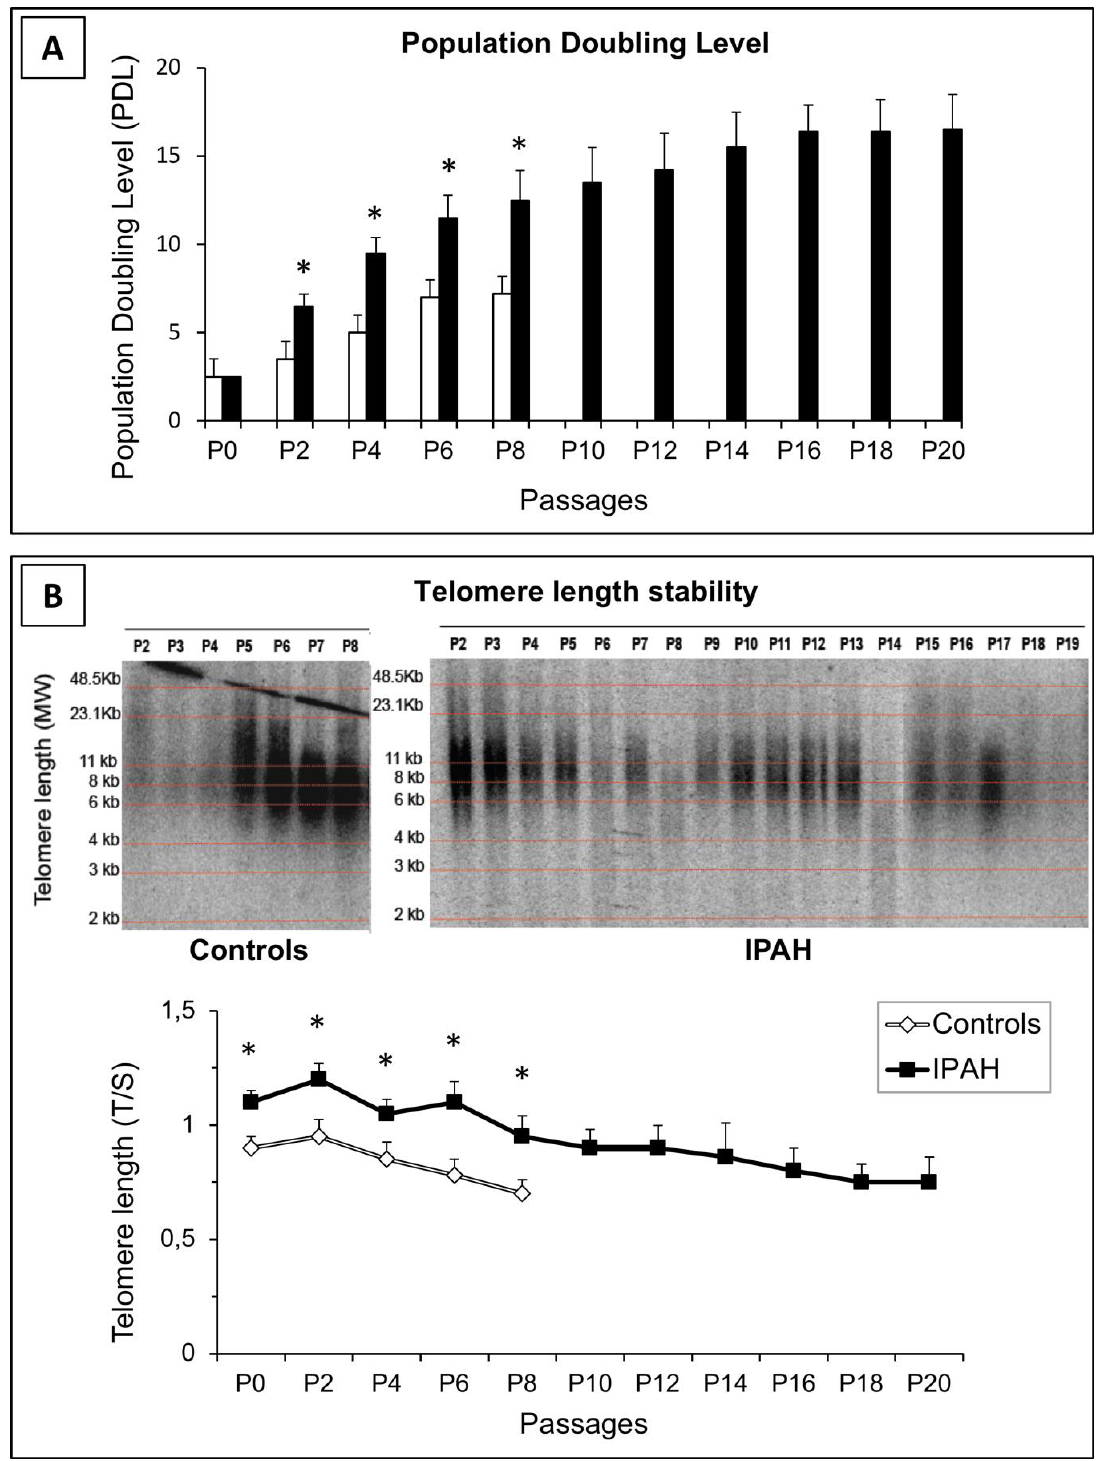
Figure 2. Growth capacity of PASMCs. ( A ) Population doubling level (PDL) was calculated at each passage by cell counting. In contrast to control cells, IPAH-PASMCs continued proliferating for many more passages. * p < 0.01. ( B ) Changes in telomere length in control and IPAH-PASMCs with advancing population doubling in vitro, as illustrated by Southern blotting (representative image) and qPCR (bottom panel). * p < 0.01 between controls and IPAH.